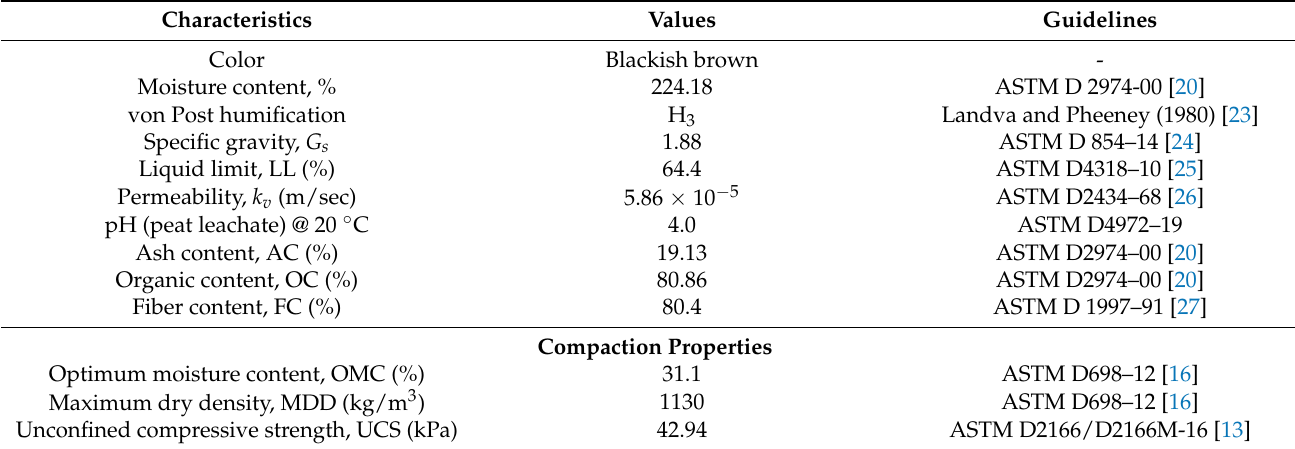
Table 5. Essential indexed and compaction properties of Teluk Intan